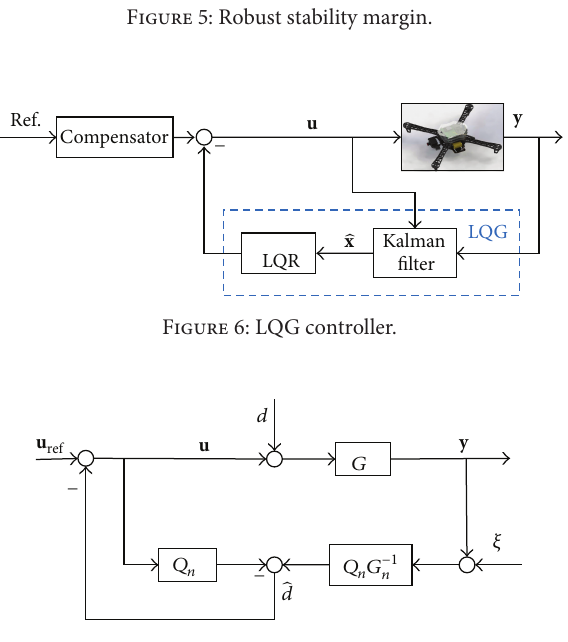
Figure 5: Robust stability margin.